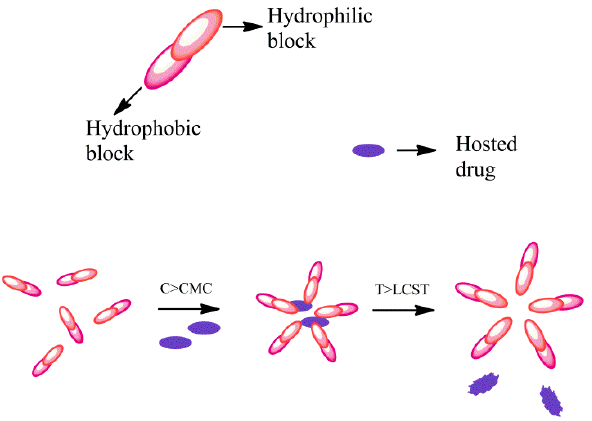
Figure 5. Scheme of behavior of thermo-responsive amphiphilic